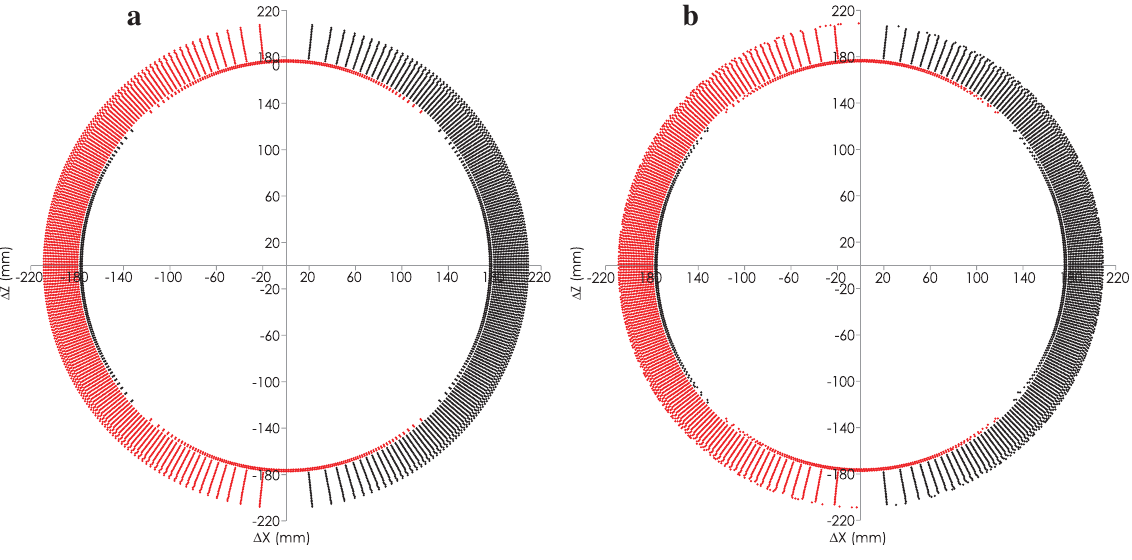
FIG. 13. Profile of the superconducting coil for the magnets of BM9 and BM10 (a) before and (b) after corrections. The coil consists of 2 layers for the quadrupole coils and 22 layers for the dipole coils. The dipole and quadrupole coils were electrically isolated, and can be independently